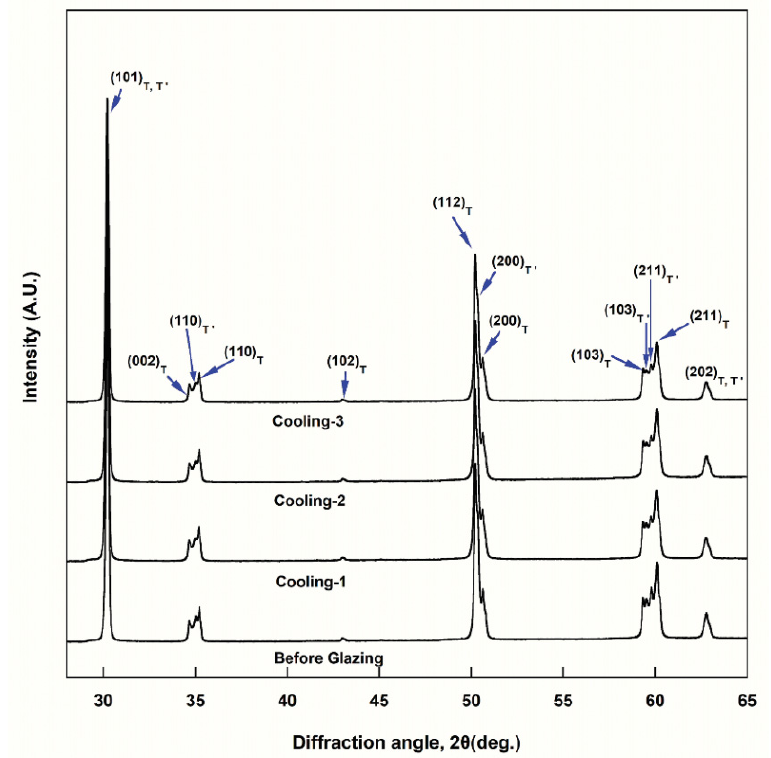
Figure 2. XRD patterns for each group of zirconia specimens.